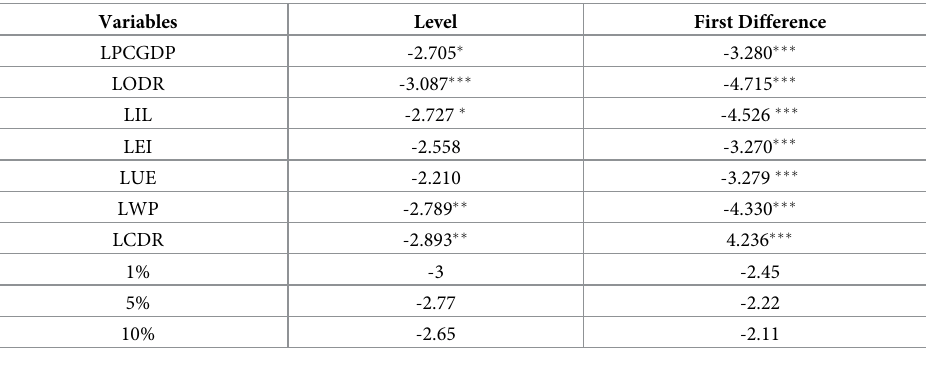
Table 9. CIPS unit root test of eastern region of